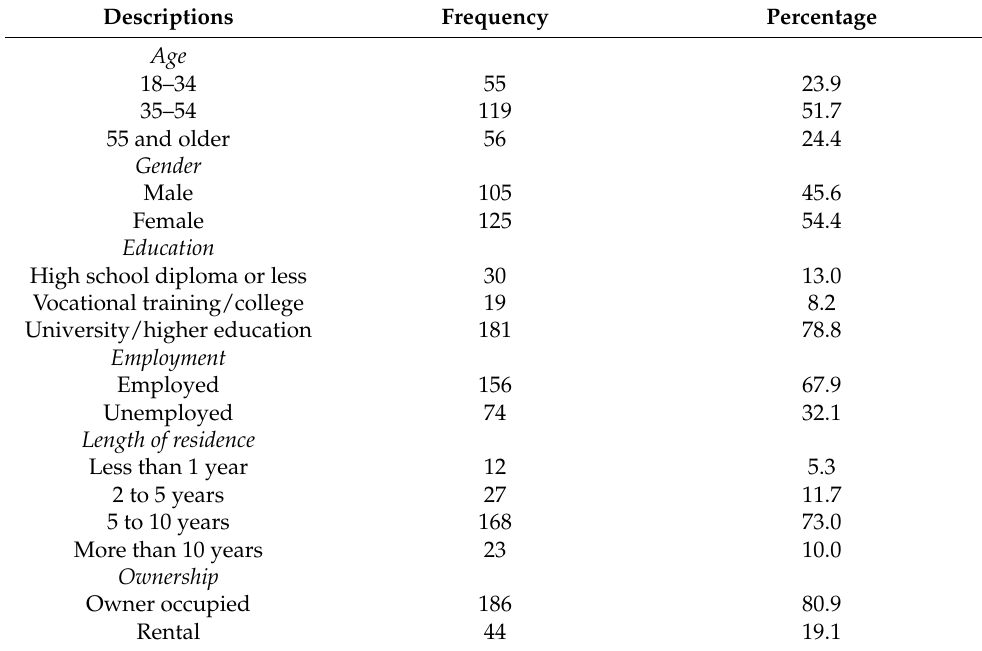
Table 1. Respondents’